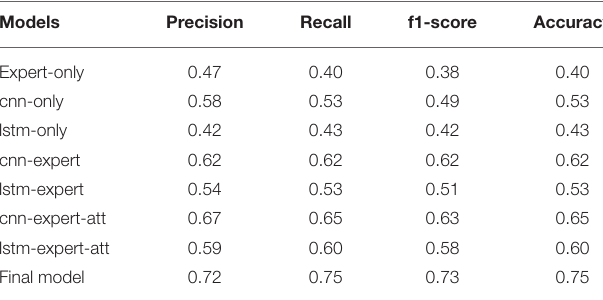
TABLE 5 | Overall precision, recall, f1score, and accuracy of all the models.